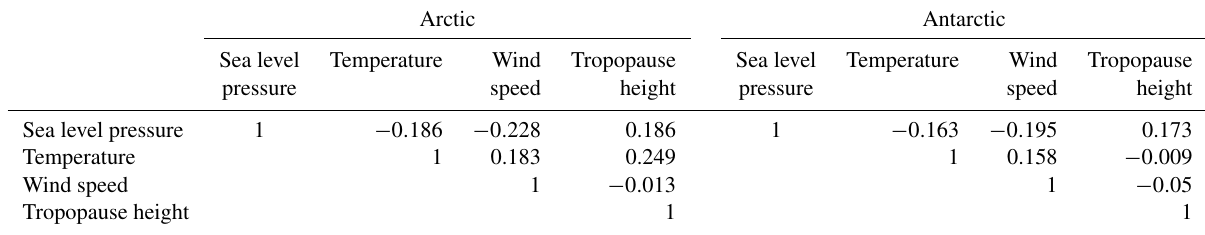
Table 4. Cross correlations of meteorological parameters for the enhanced total BrO cases in the Arctic and Antarctic sea ice regions. Arctic Antarctic Sea level